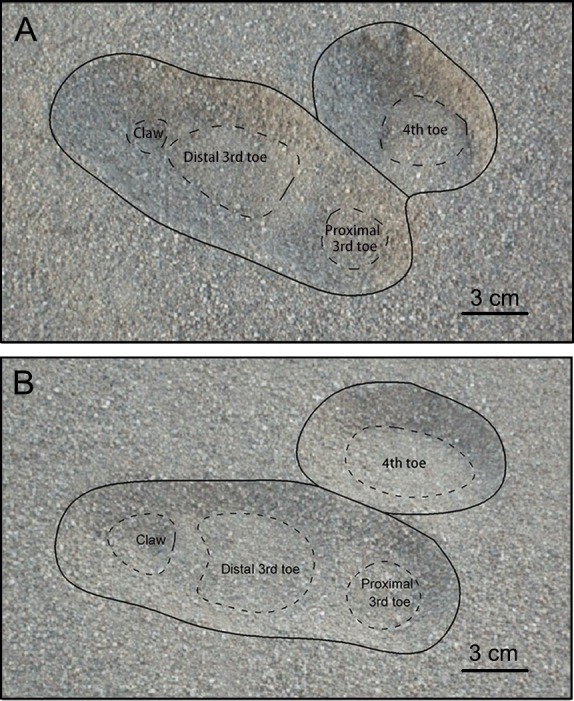
Footprints of ostrich right foot when (A) running and (B) walking on loose sand.The black solid lines show the region of disturbed sands. The dashed lines show the region of sand solidified and flatted by different parts of ostrich foot. An obvious hump appeared between the distal and proximal parts of the 3rd toe in both running and walking trials.